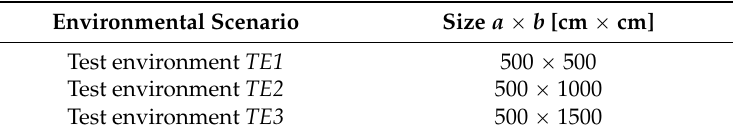
Table 2. Environmental